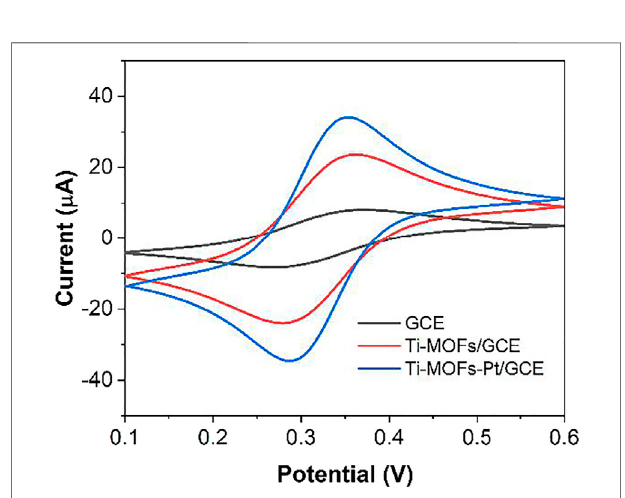
Frontiers in Chemistry |